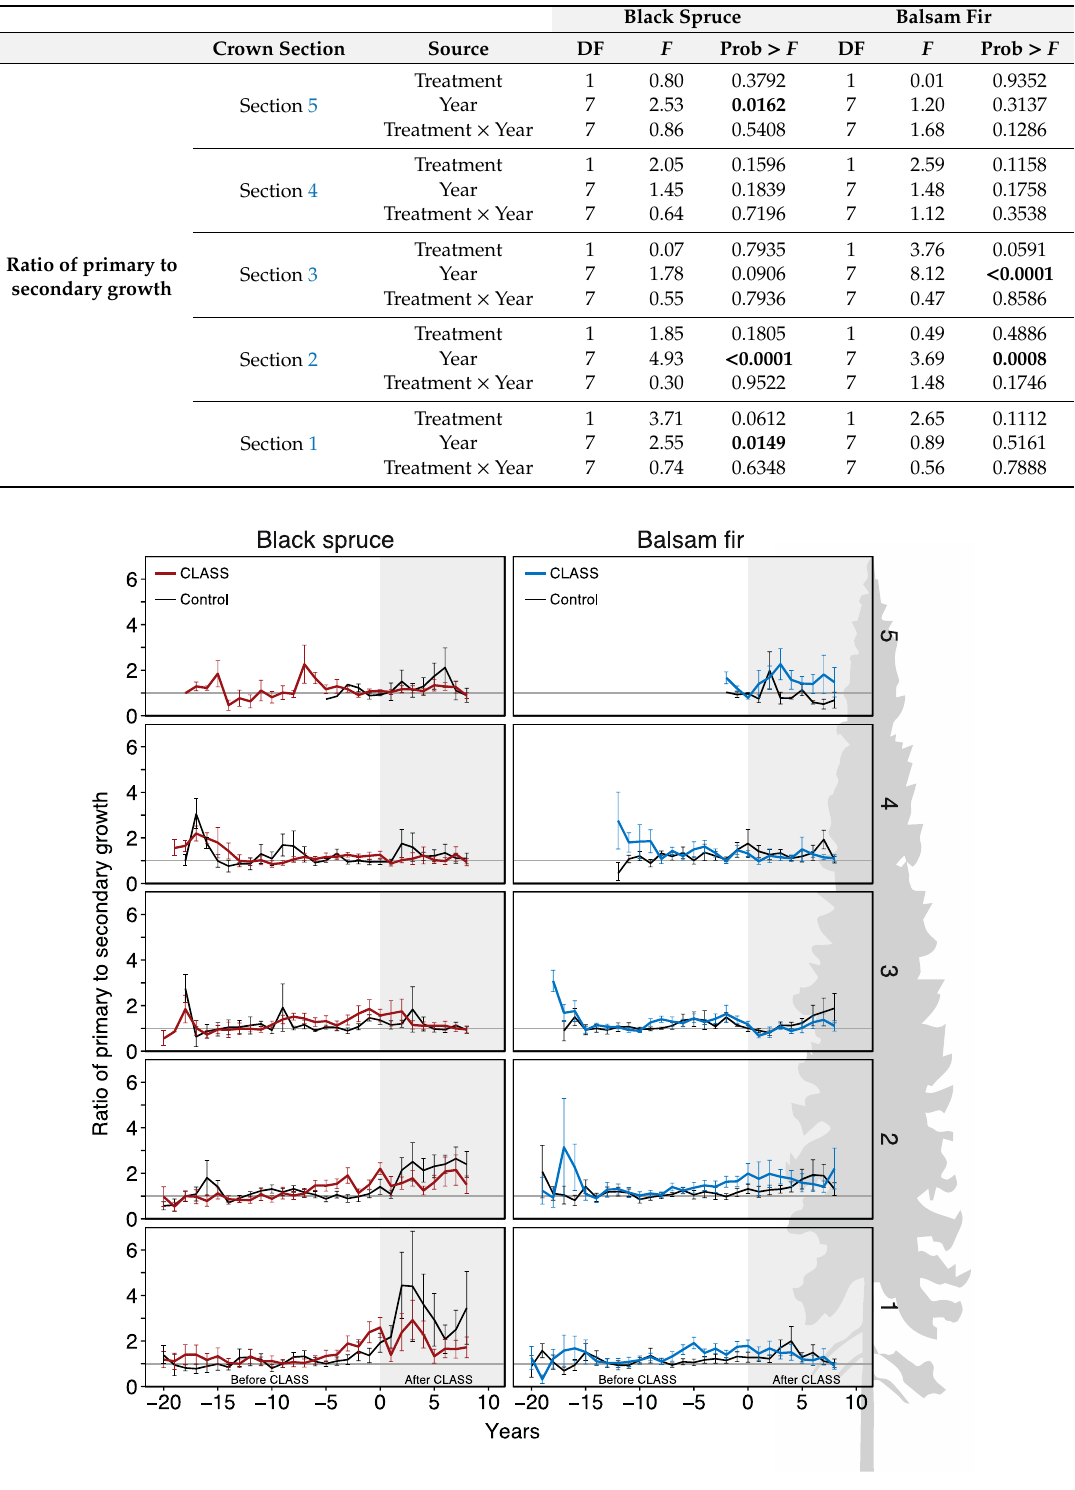
Figure 5. Mean ratio of primary to secondary growth (± se) of branches in the five sections of the live crown for black spruce and balsam fir before and after CLASS. The grey area represents the years post-treatment, with Year 0 being the treatment year.